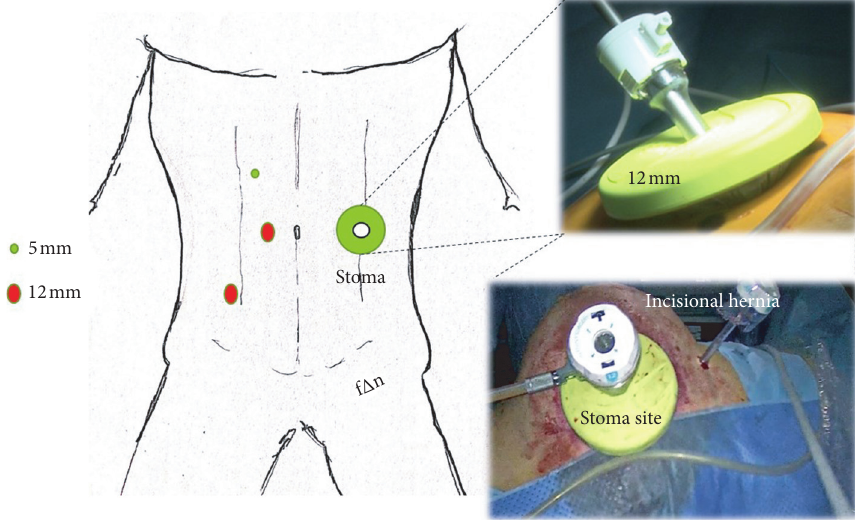
Figure 1: Trocar’s positions with Alexis ® wound protector.